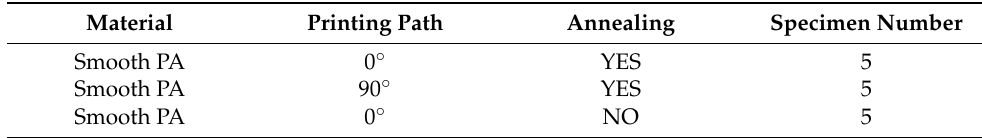
Table 1. Chopped FRP specimens test